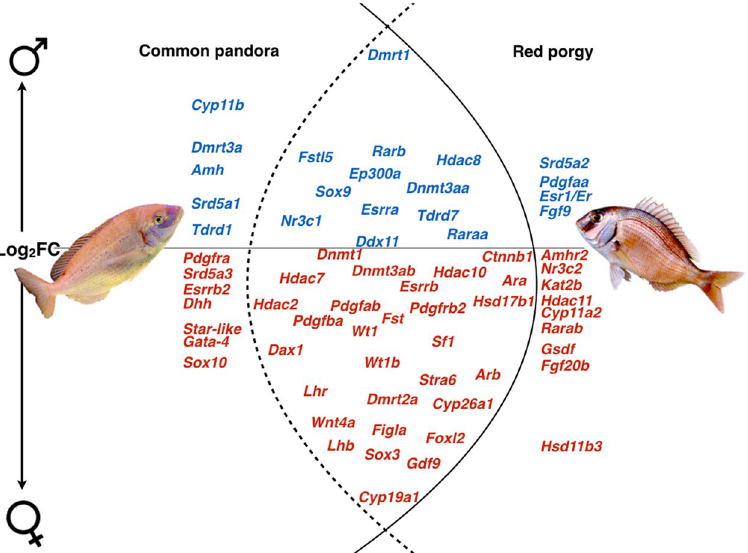
Figure 6. Comparative view of known sex-related genes, commonly (intersection) and uniquely expressed in common pandora (left) and red porgy (right). Above and below the central line are the male-specific (Blue) and the female-specific (Red) genes. The Y-axis serves as an indication of expression magnitude (in terms of Log2Fold-Change differences). The commonly expressed genes (intersection) are placed according to their Log2Fold-Change values in common pandora and had an analogous expression magnitude in red porgy. The genes uniquely expressed in each species are placed according to their expression values in that particular